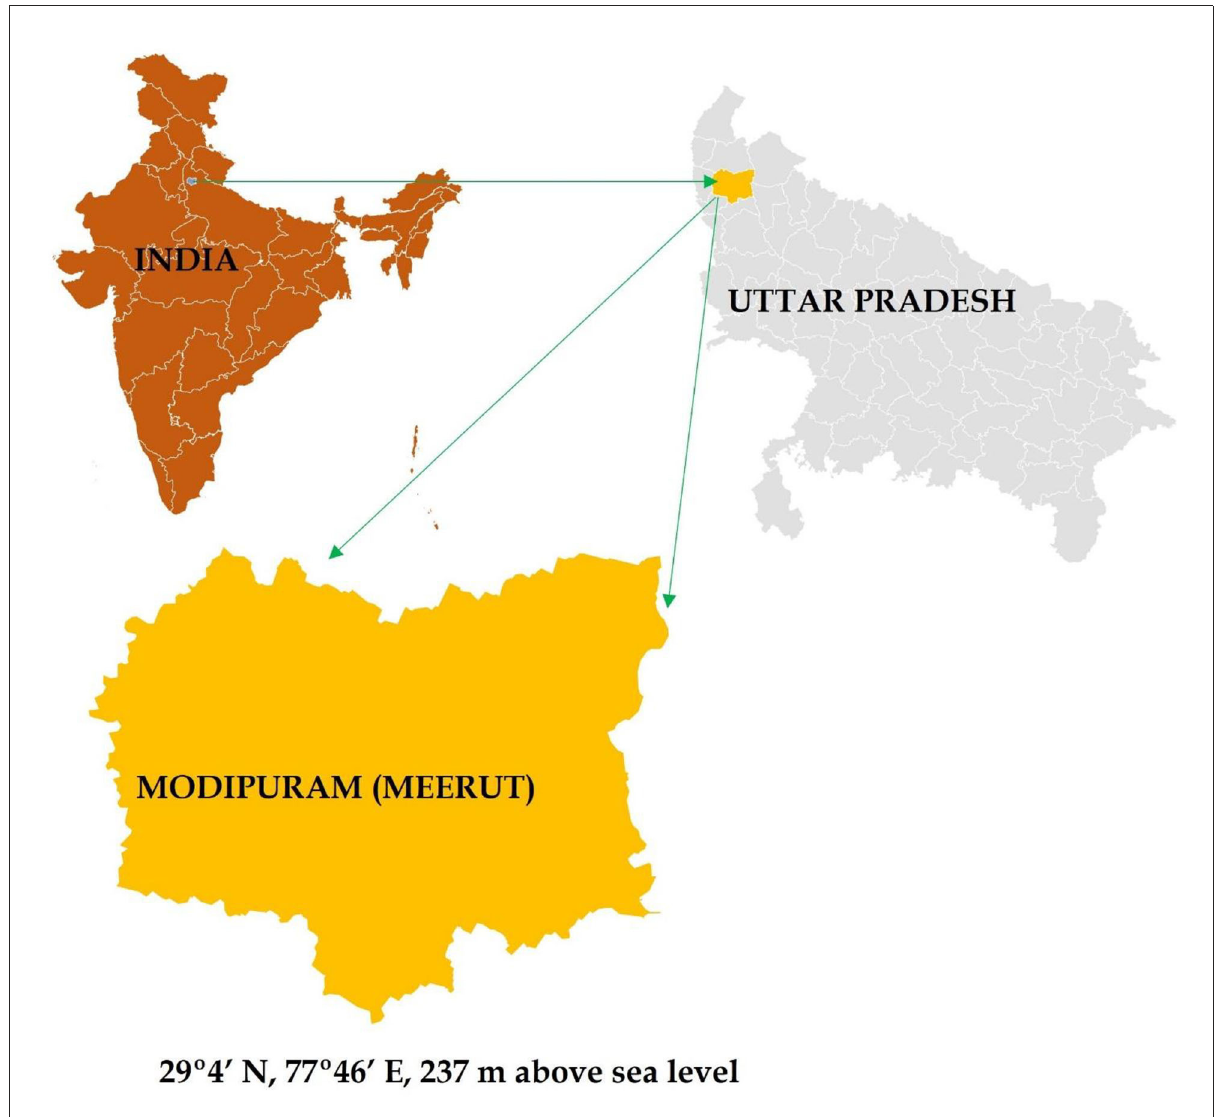
FIGURE2 Experimental site of long-term rice-wheat cropping system